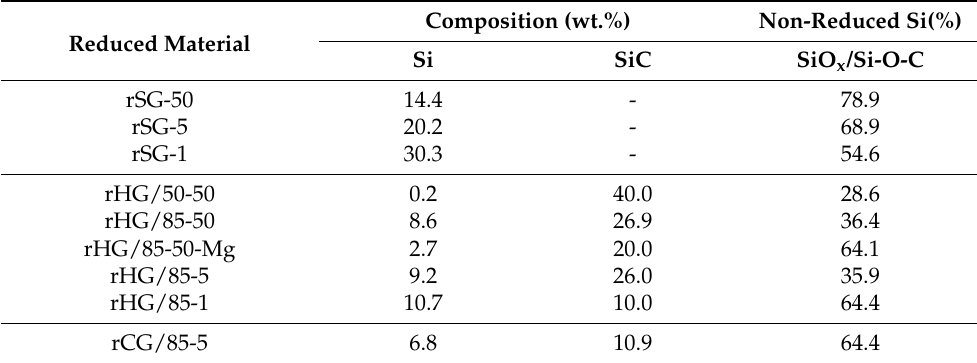
Table 3. Content of Si and SiC determined by XPS analysis, and the percentage of silicon remaining in nonreduced compounds in the materials